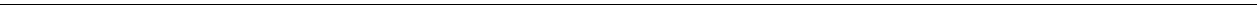
Figure 3 | Mutability landscapes of 4-OT for tautomerase and promiscuous ‘Michaelase’ activities. The horizontal axes of the data matrices depict the wild-type sequence of 4-OT and the vertical axes depict the 20 possible amino acid residues. The wild-type amino acid residue at each position is indicated by bold squares. Grey boxes represent mutants that were not produced above the detection limit (0.5mgml (cid:2) 1 in the CFE) and white boxes represent mutants that were not present in the collection. The colour indicates the specific activity of each mutant relative to that of wild-type 4-OT (( U mut (cid:3) mg (cid:2) 1 )/( U wt (cid:3) mg (cid:2) 1 )). All activities were determined using ultraviolet spectroscopy (details can be found in the Methods section) and enzyme concentrations in CFE were individually determined for each 4-OT variant using quantitative densitometric analysis of SDS gels. Each screening plate contained samples of wild-type 4-OT of which the average specific activity was used to calculate the relative specific activities of all 4-OT variants on that same plate. ( a ) The mutability landscape of 4-OT for tautomerase activity using substrate 8 ( n ¼ 4). ( b ) The mutability landscape of 4-OT for the Michael-type addition of 3 to 5a ( n ¼ 2). ( c ) The mutability landscape of 4-OT for the Michael-type addition of 4 to 5a ( n ¼ 2). ( d ) The secondary-structure elements of 4-OT 20